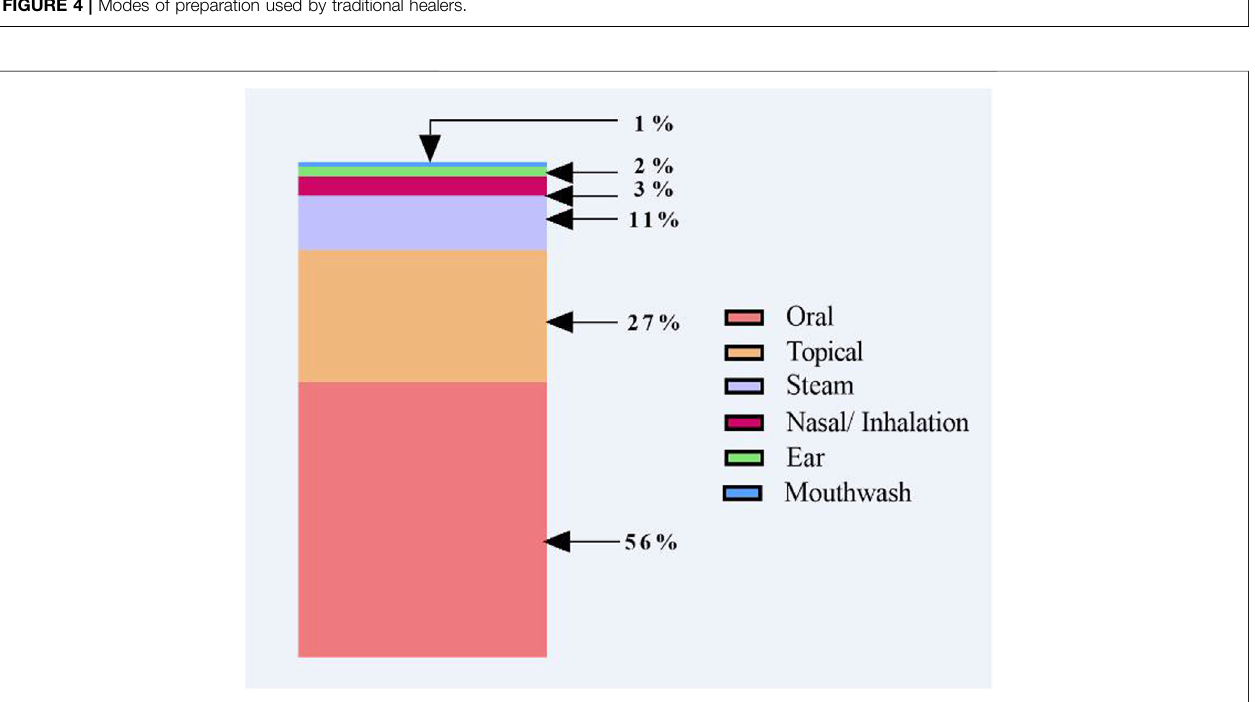
FIGURE 4 | Modes of preparation used by traditional healers.